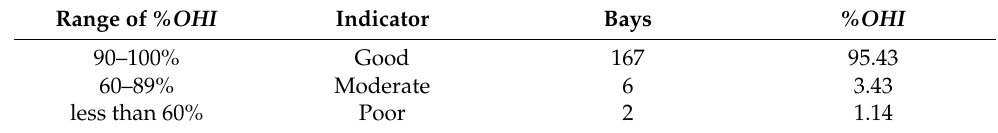
Table 14. Number of bays and their %OHI according to their